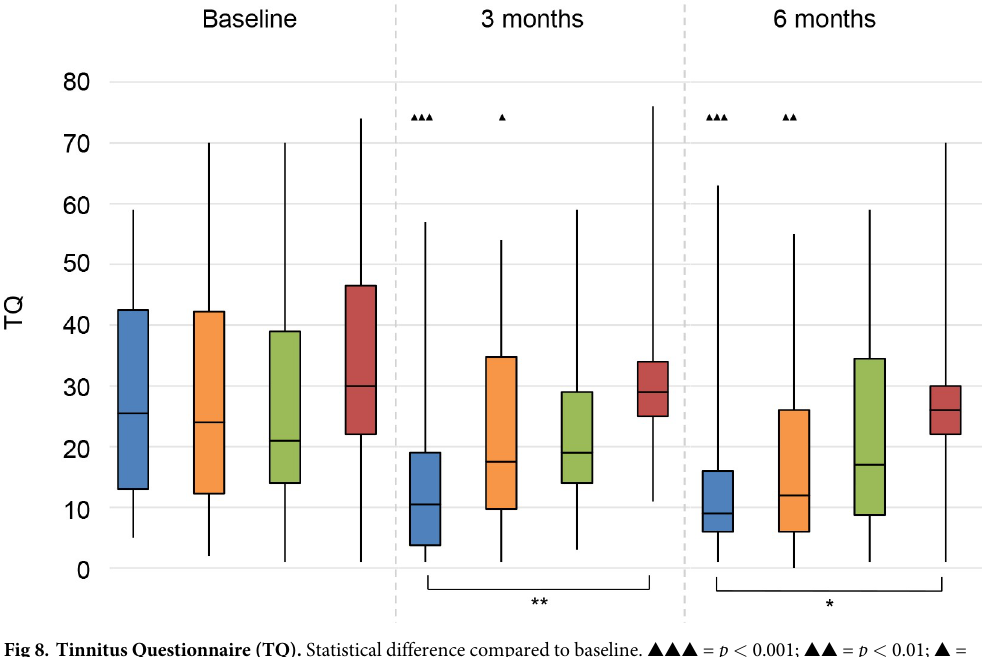
Fig 8. Tinnitus Questionnaire (TQ). Statistical difference compared to baseline. ▲▲▲ = p < 0.001; ▲▲ = p < 0.01; ▲ = p < 0.05. Statistical difference compared to 3 months follow-up. ■■■ = p < 0.001; ■■ = p < 0.01; ■ = p < 0.05. Statistical difference between groups at same follow-up moment. ��� = p < 0.001; �� = p < 0.01; � = p <